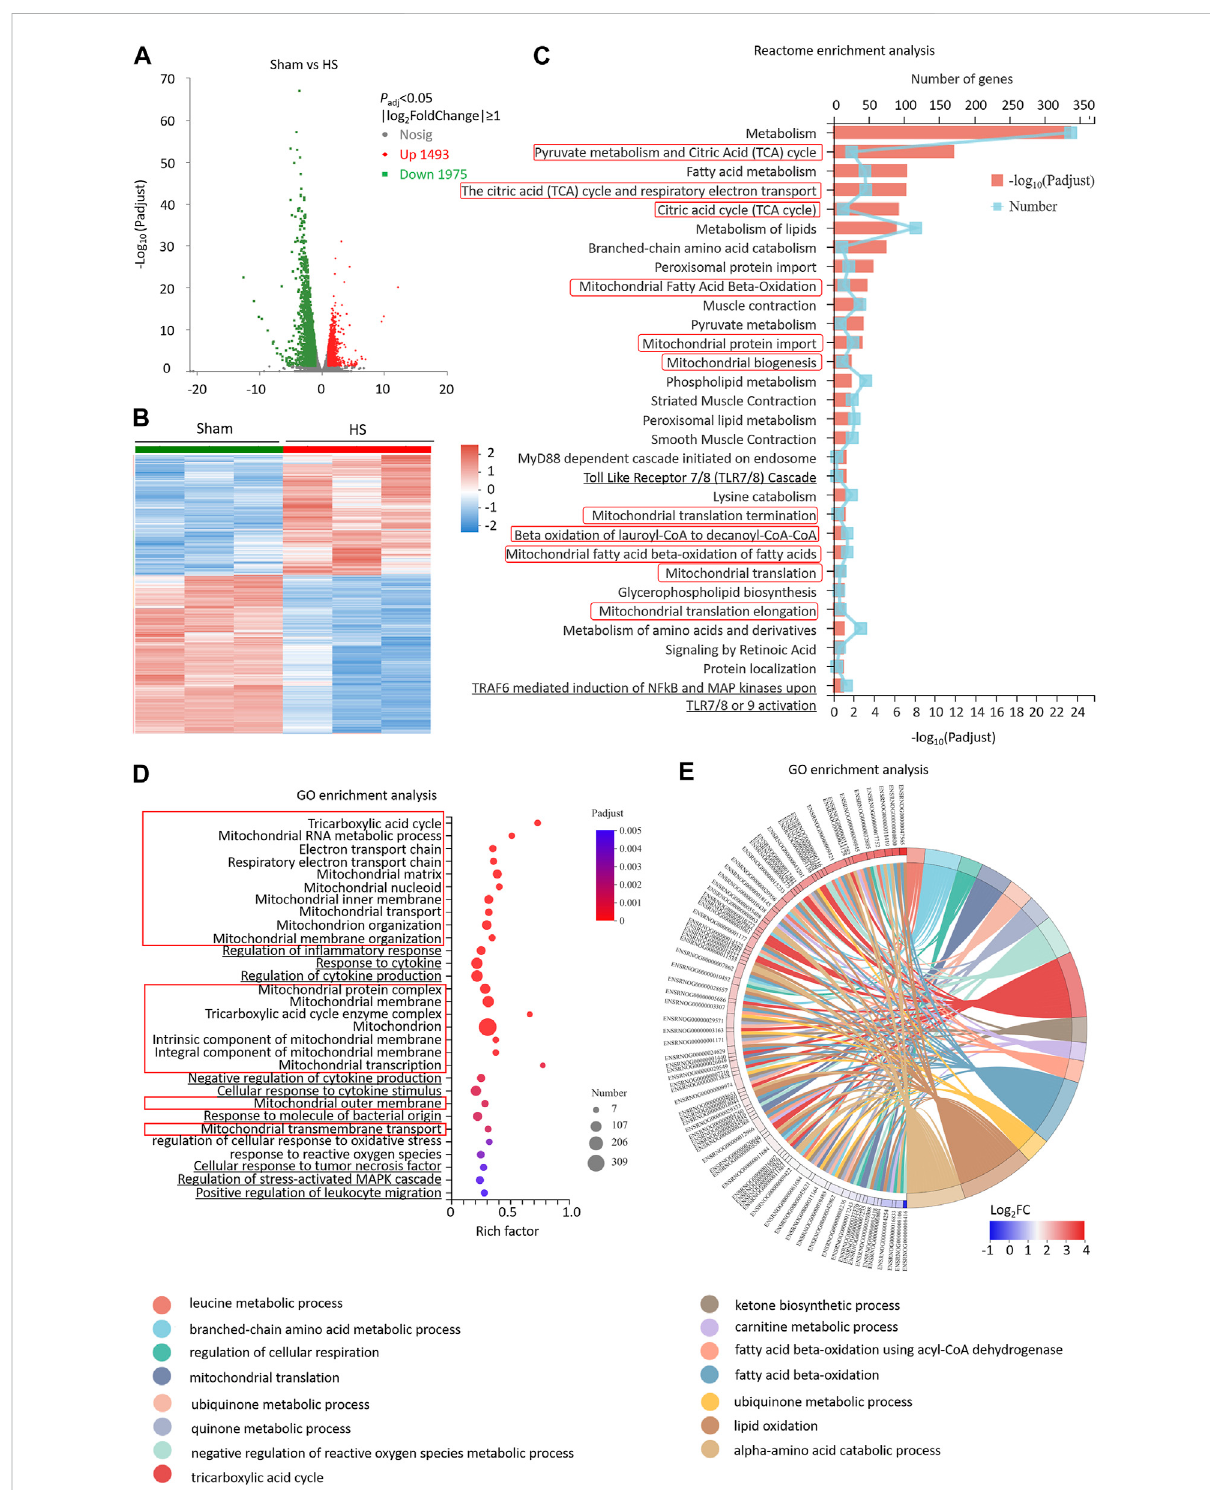
FIGURE 2 DifferentiallyexpressedgenesofmyocardialtissuesafterHSaresigni fi cantlyenrichedinmitochondrialandROSpathways. (A) Thevolcanoplot showing number of differentially expressed genes (DEGs)of HS and sham rat heart tissues; P adj < 0.05, n = 3 rats per group. (B) A heat map summary of the DEGs expression values of HS and sham group. Red indicates high and green indicates low gene expression P adj < 0.05, n = 3 mice per group. (C) Reactome enrichment analysis and (D) GO enrichment analysisof all the DEGs and GO cluster plot showing achord dendrogram (E) of the clustering of the expression spectrum of the 309 DEGs in the mitochondrion GO term between sham and